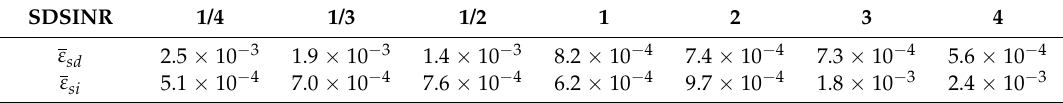
Table 3. Estimation errors of SD and SI noise on the synthetic HS image with various SDSINR